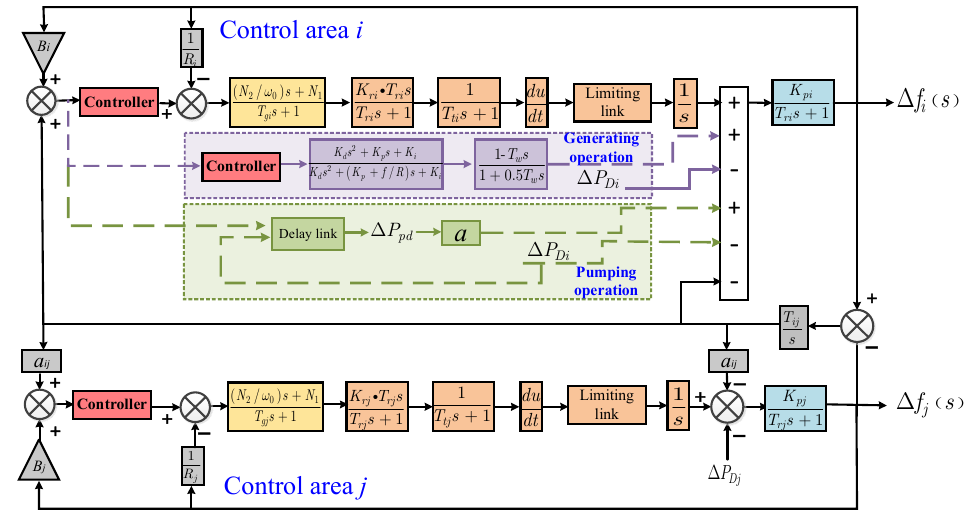
Figure 3. Pumped storage power station model.